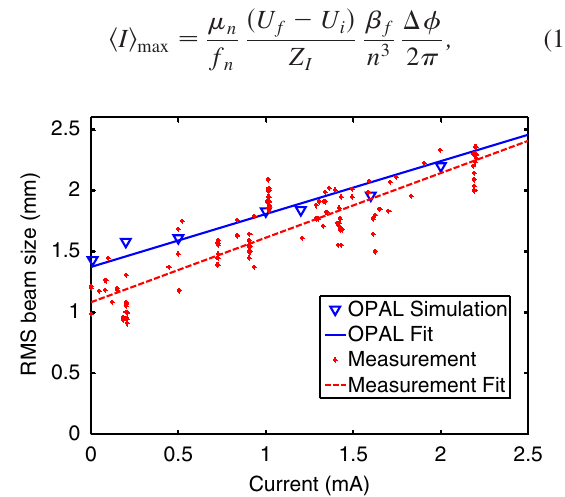
FIG. 9. Radial beam size at extraction vs beam current.